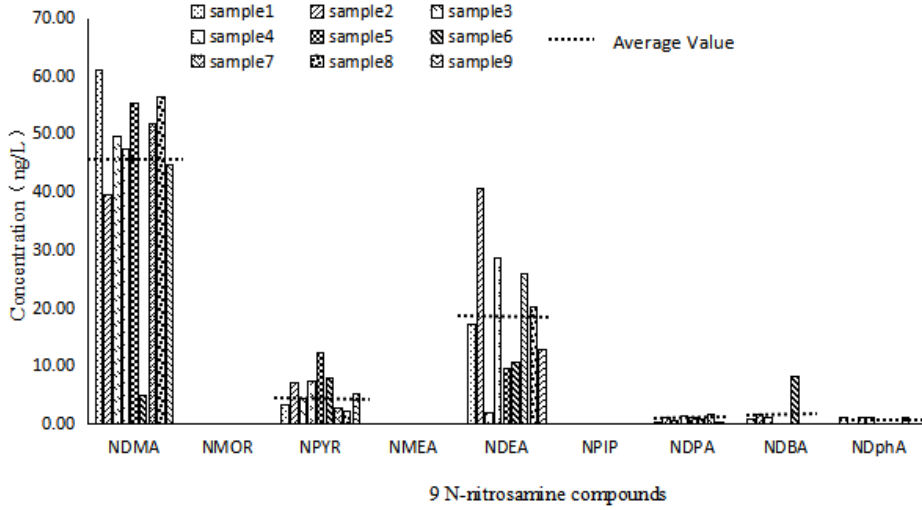
Figure 2. Distribution of 9 nitrosamines in 9 samples.